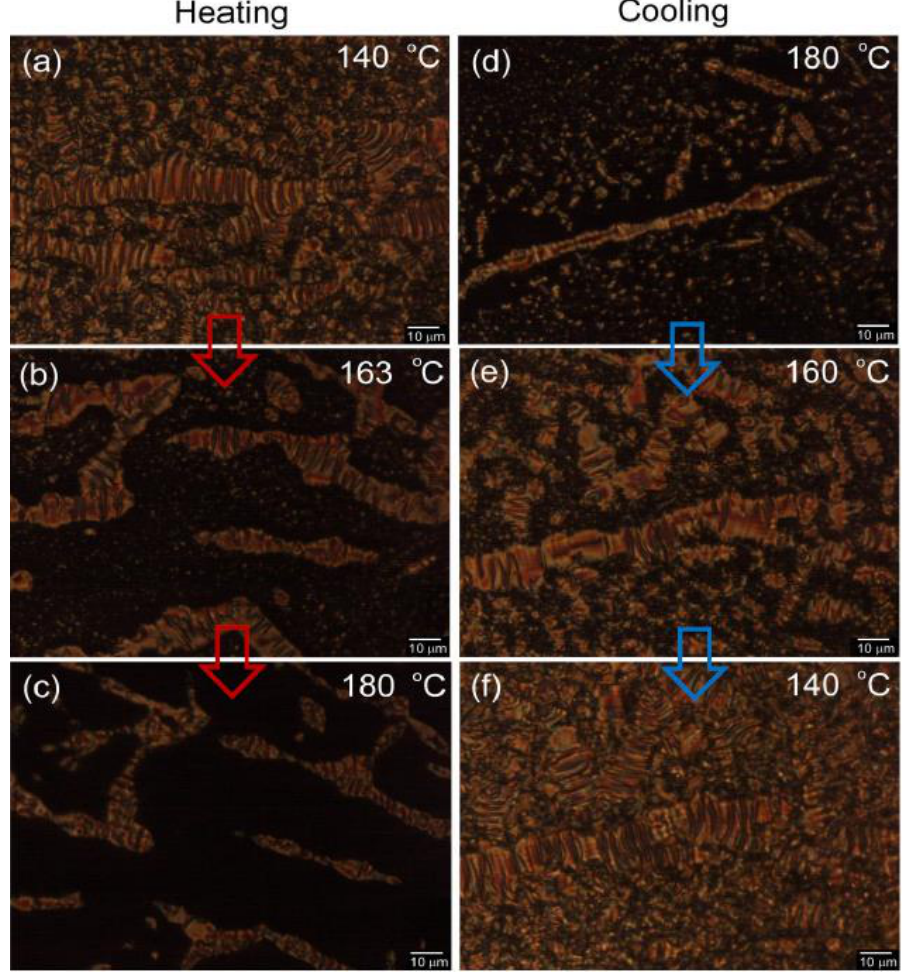
Figure 8. POM images of the SmC*–LC–poly(Ar–Pyr) blend with the chiral inducer on heating ( a – c ) and cooling ( d – f ).